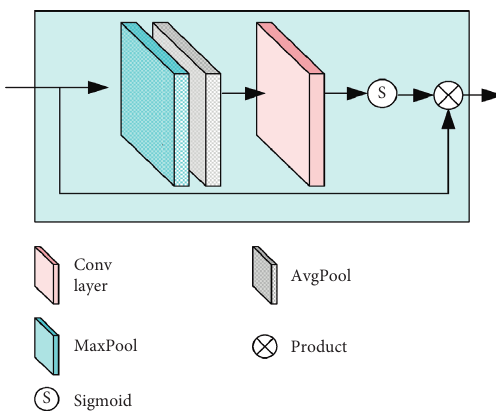
Figure 8: Spatial attention block. We introduce this module after the convolution layer of the subnetwork is extracted from the static feature, which gives the difference attention to the local area of the